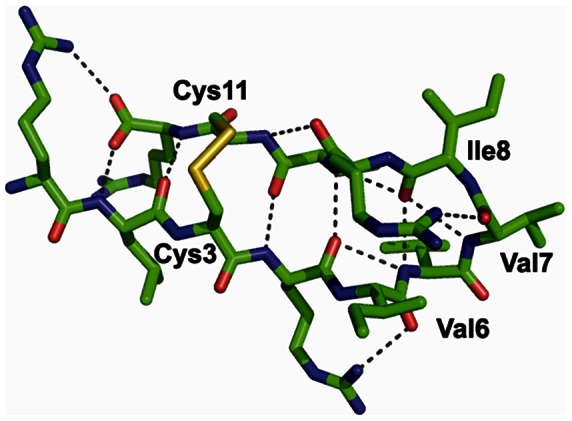
β-hairpin model of bactenecin in the oxidized state.Cys3-Cys11 disulfide bond in gauche-gauche-gauche conformation is formed in the non hydrogen-bonding pair; the 3-residue β-turn is formed by Val6-Val7-Ile8 residues in αRγRαL conformation [56].